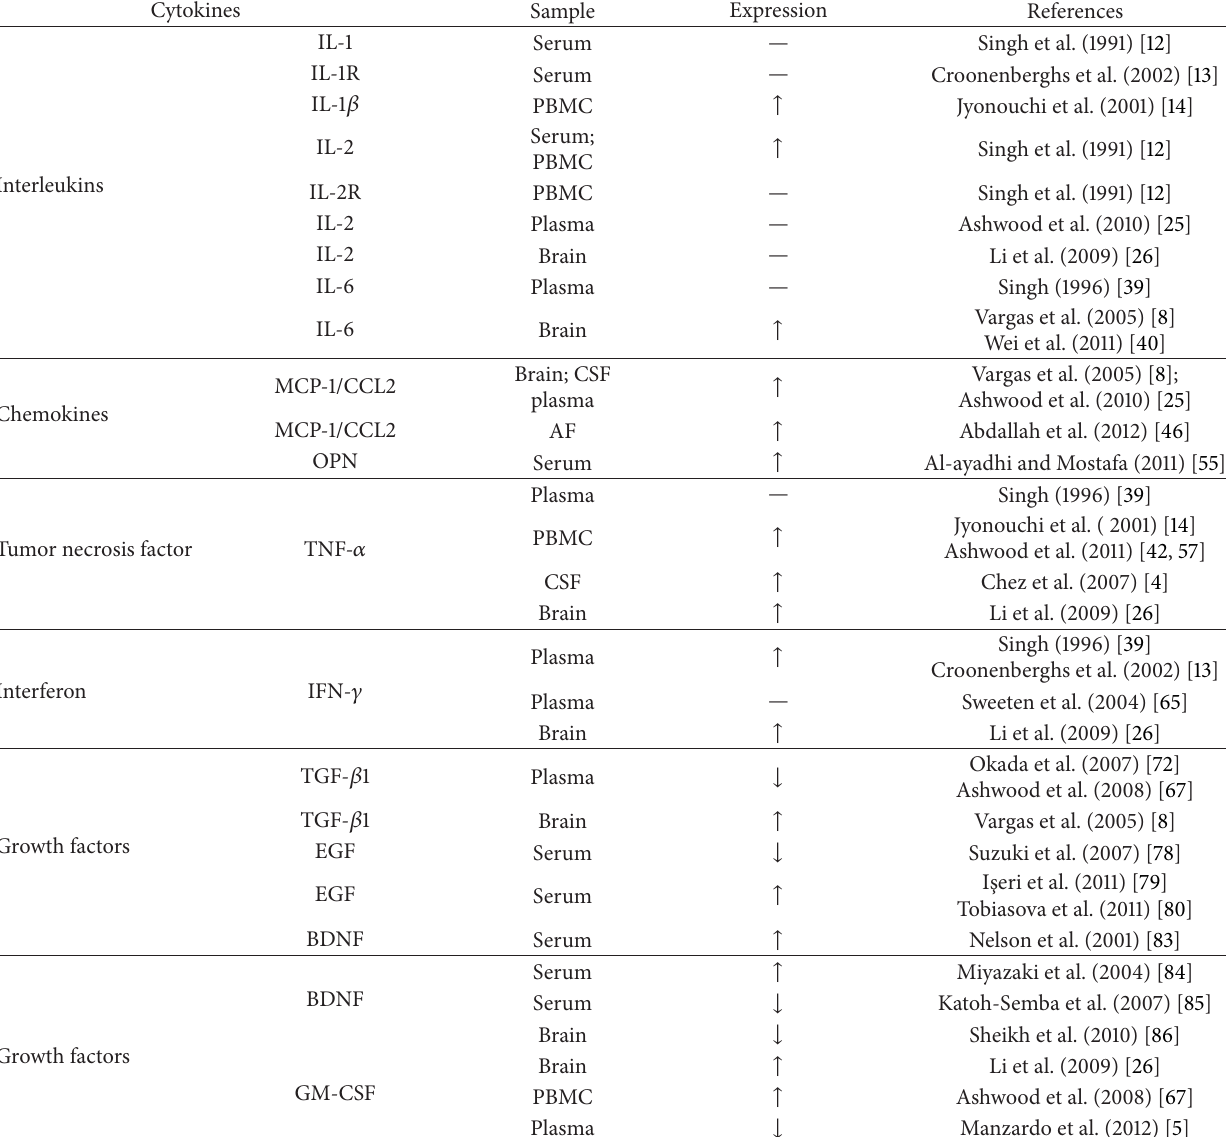
Table 1: The expression of cytokines in different samples of autistic